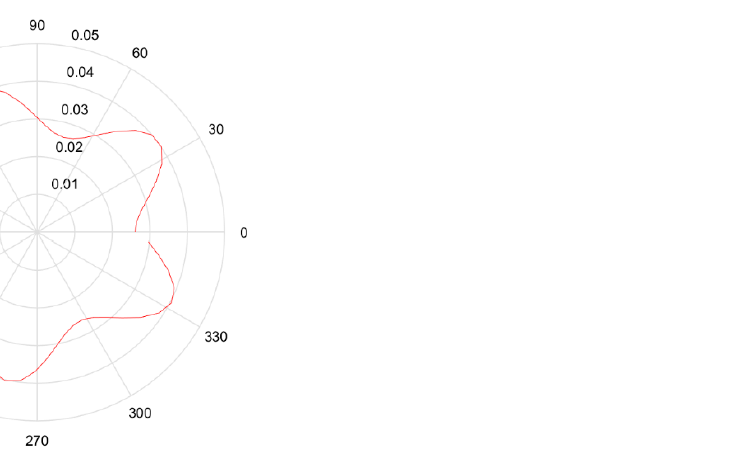
Figure 8. Polar diagram for paths described by a point at ρ = 350 mm with a 217/37 gear ratio and a solar radius of 620 mm undergoing a single revolution.